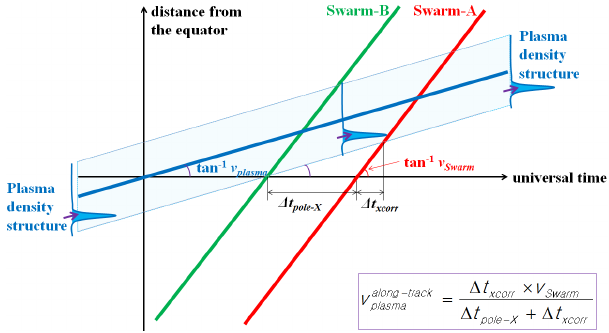
Figure 1. A schematic diagram showing the relative motion of the Swarm satellites and plasma density